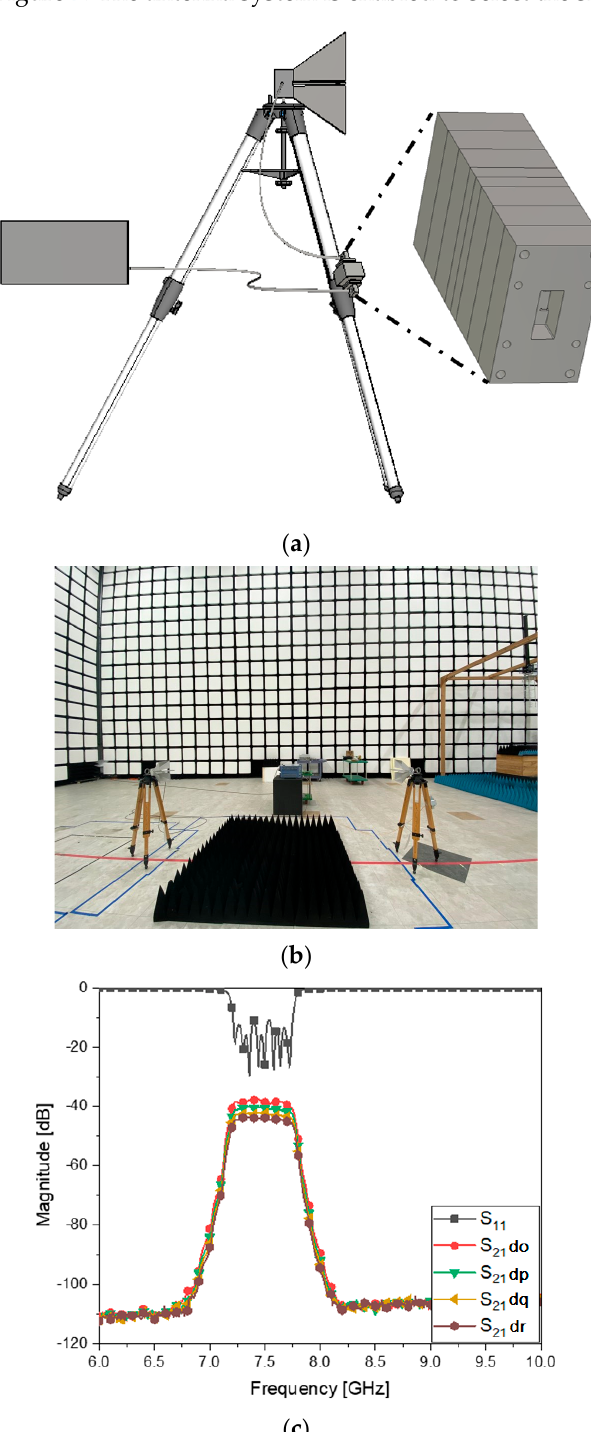
Figure 11. RF − link and channel selectivity test. ( a ) Case of the TX as the filtenna that comprises the BPF and the antenna. ( b ) Over − the − air test. ( c ) S 11 and S 21 when the setup places the BPF in the feed for the TX antenna.